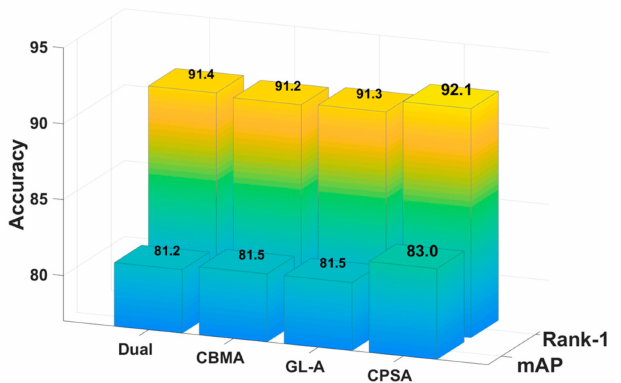
Figure 11. The comparative experiments of CPS-Attention on